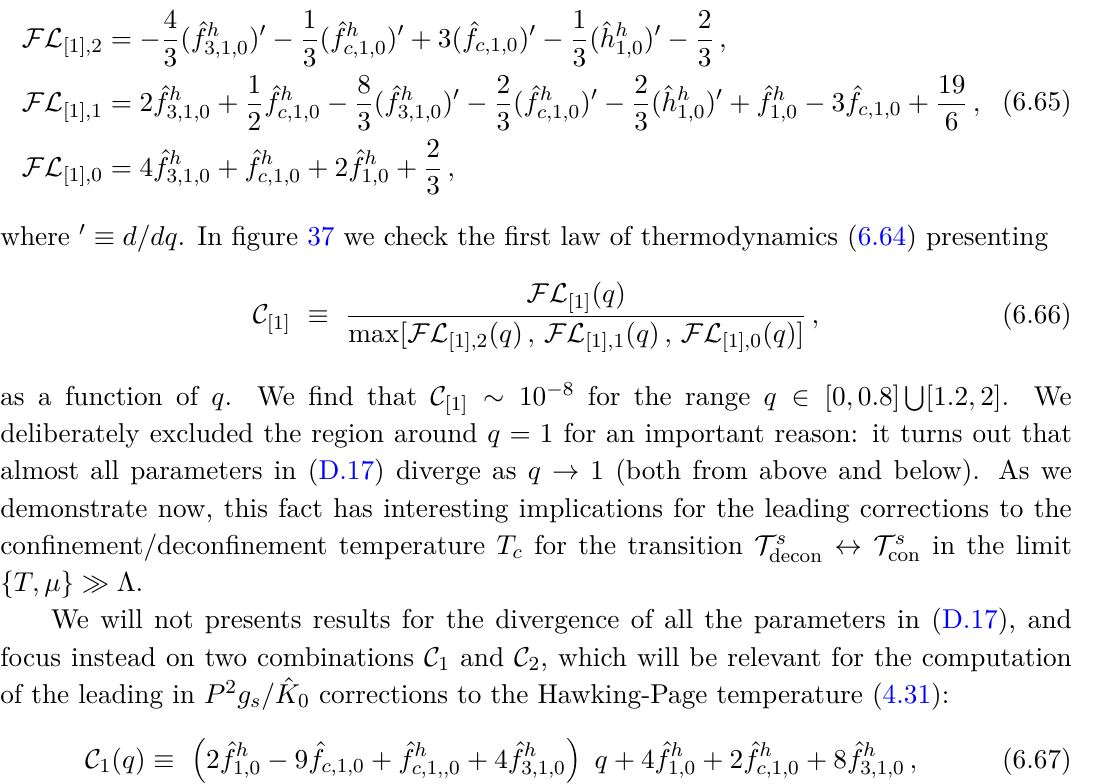
(the left panel) and